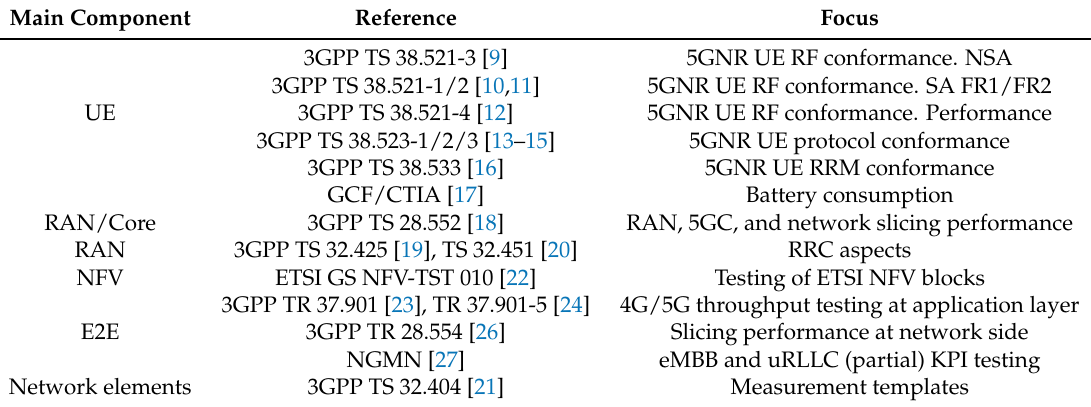
Table 1. Summary of standards for 5G testing and Key Performance Indicator (KPI)